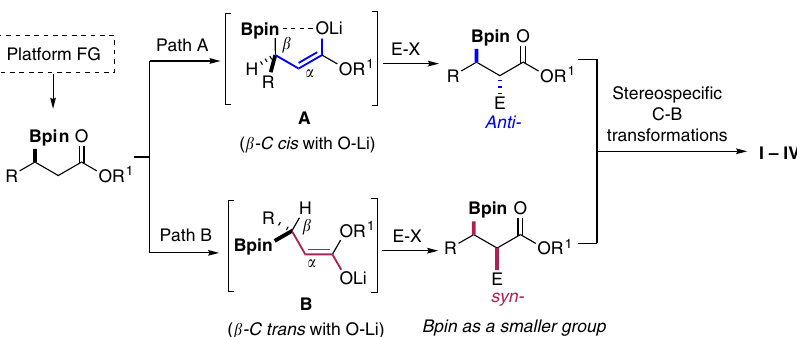
Fig. 1 β -Controlled α -alkylation of carbonyl compounds. a Possible strategies in β -controlled construction of contiguous α , β -stereodiads. b Boronyl group- controlled uni fi ed approach to stereodiads via α -functionalization of β -boronyl